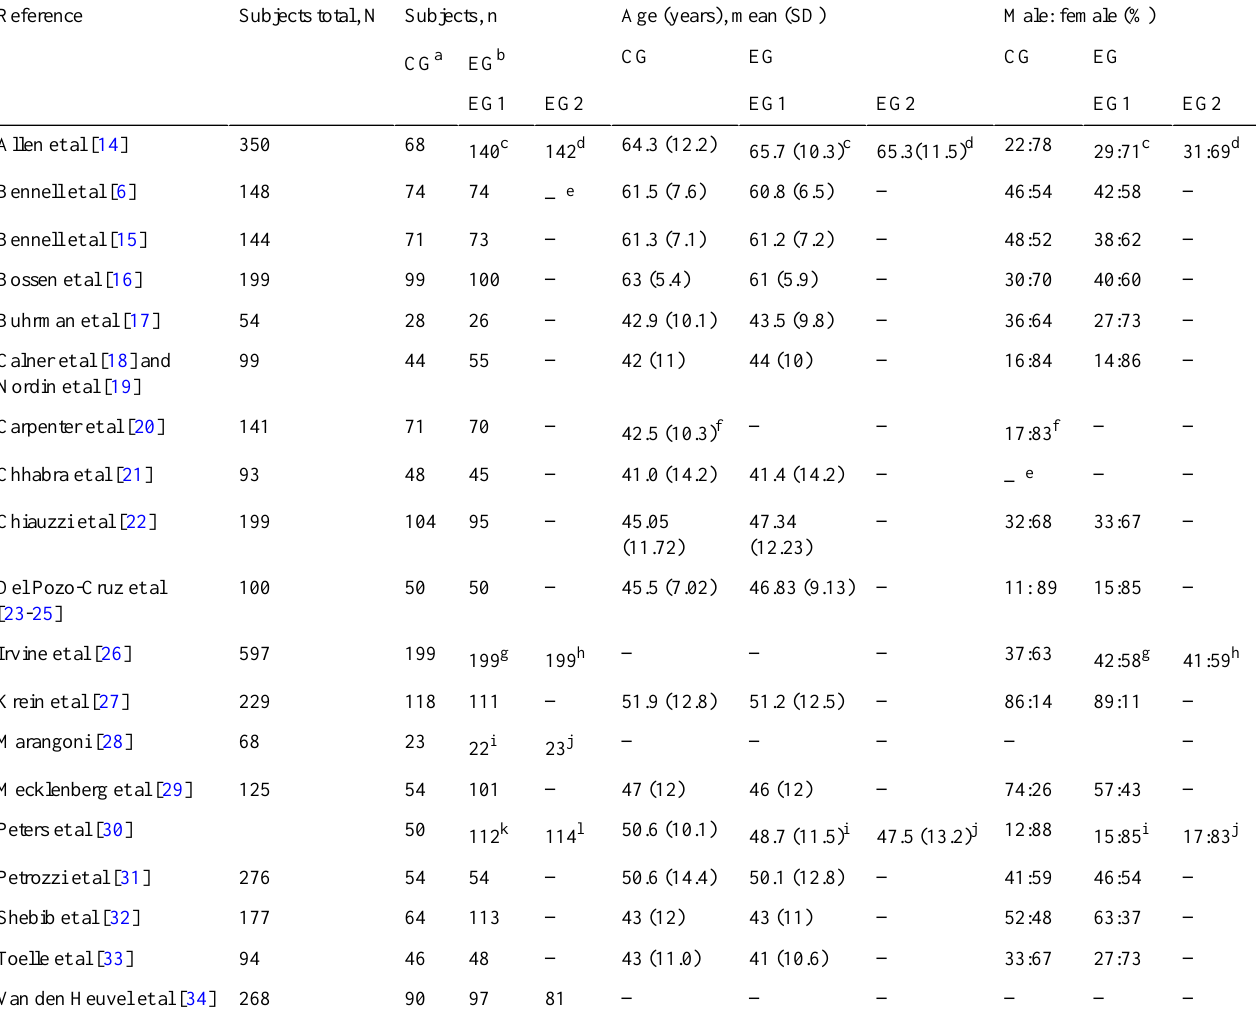
Table 1. Study and participant